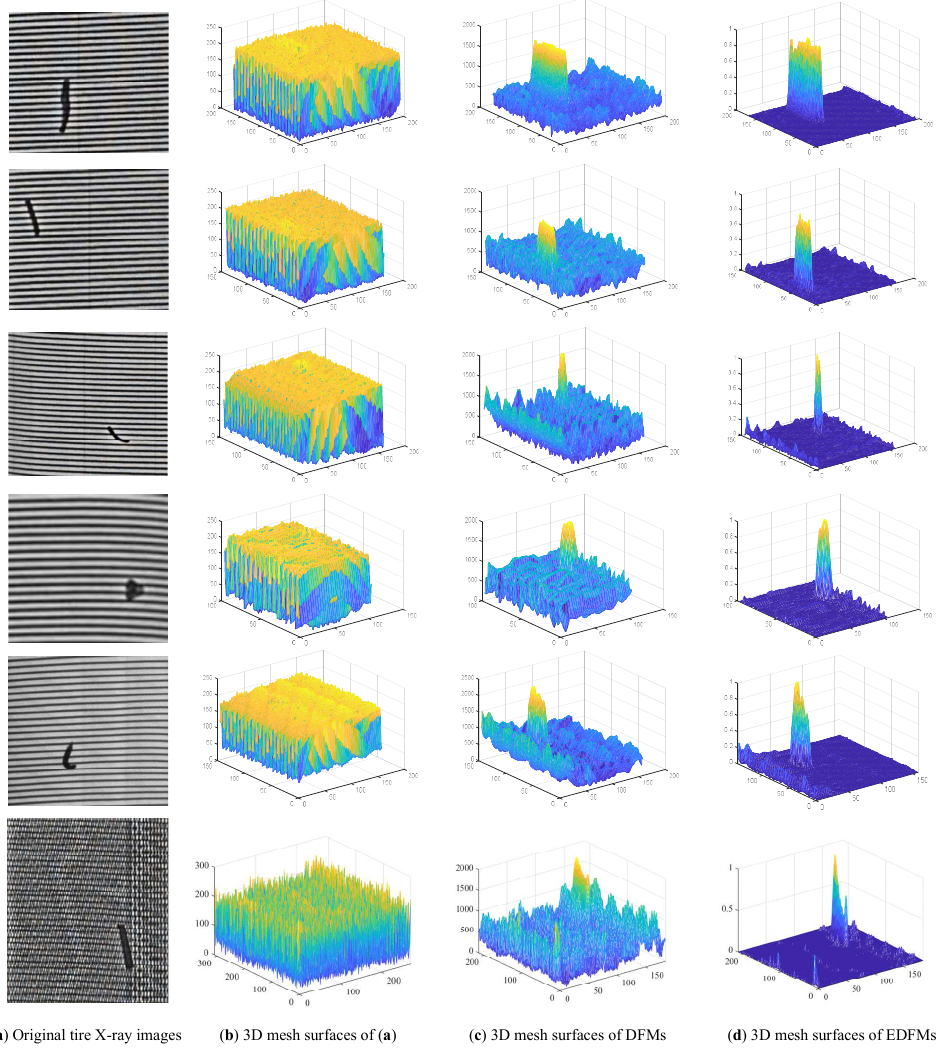
Figure 10. Construction of DFM and